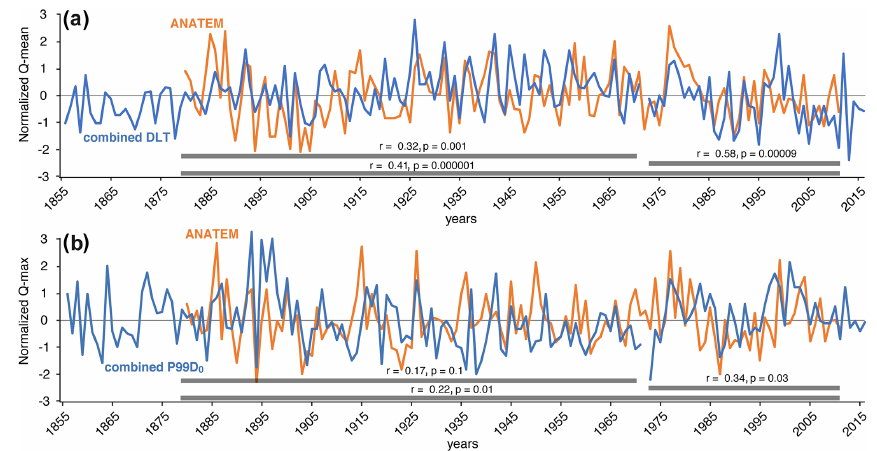
Figure 10. Comparison between the Naskaupi River (a) Q -mean and (b) Q -max reconstruction using combined detrital layer thickness (DLT) (without the NAS-1 1972–2016 period) and P99D 0 series respectively (blue line) and the rainfall–runoff modelling (orange line) for raw yearly